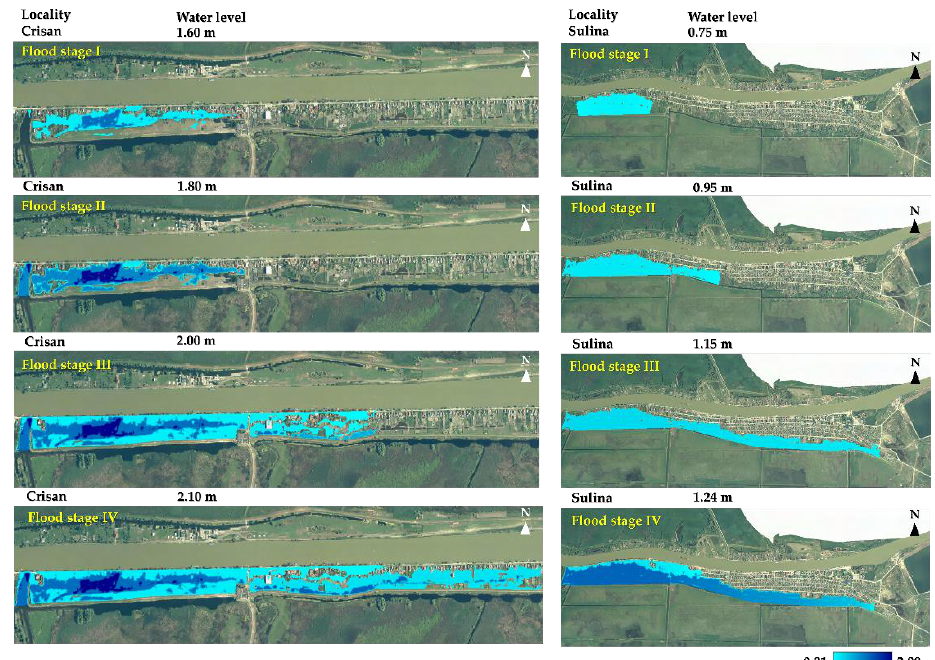
Figure 12. Flood scenarios maps for Maliuc (first column group of subfigures), Mila 23 (second column group of subfigures), and Gorgova (third column group of subfigures) settlements, corresponding to the condition of 7 July 2010, by using the 1D/2D HEC-RAS model, at high resolution DTM 0.5 m × 0.5 m, dynamic method.